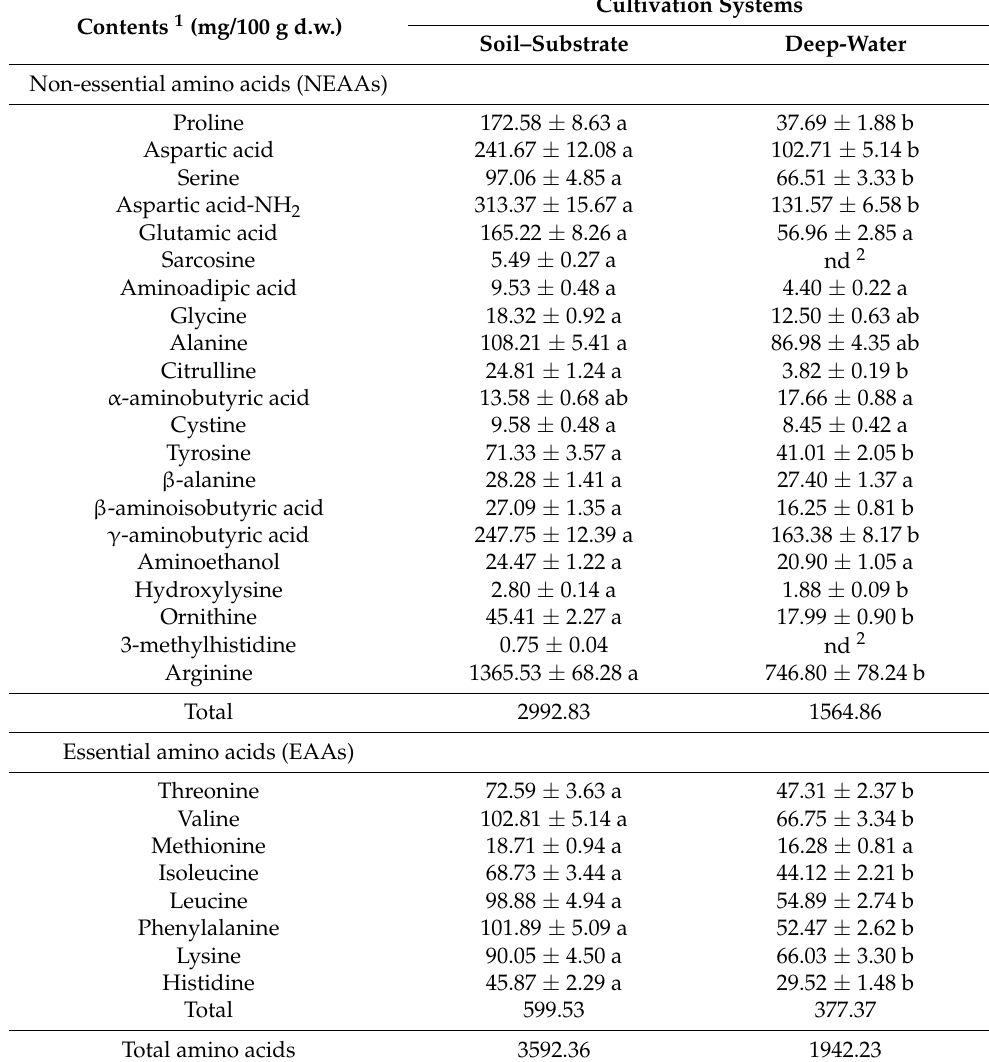
Table 2. Comparison of free amino acid contents of PGS in different cultivation systems in a plant factory. Contents 1 (mg/100 g